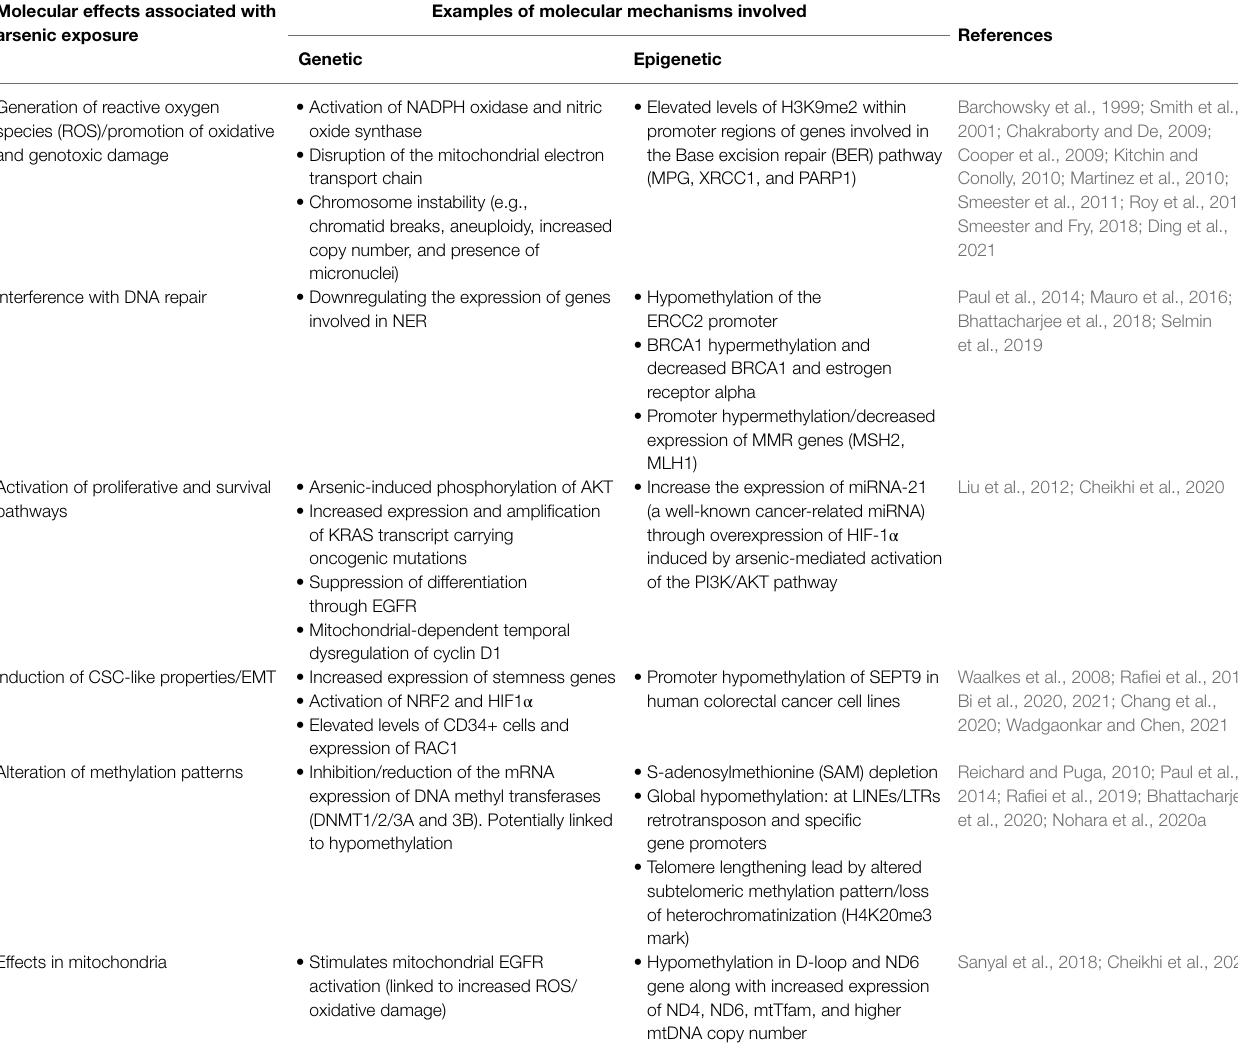
TABLE 1 | Genetic and epigenetic molecular changes associated with arsenic